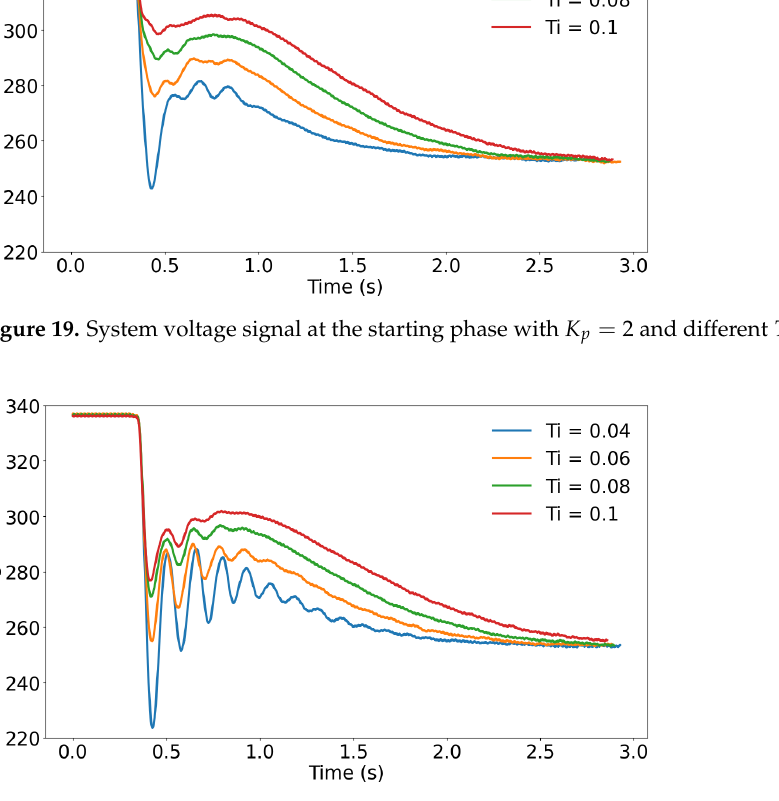
Figure 20. System voltage signal at the starting phase with K p = 3 and different T i .